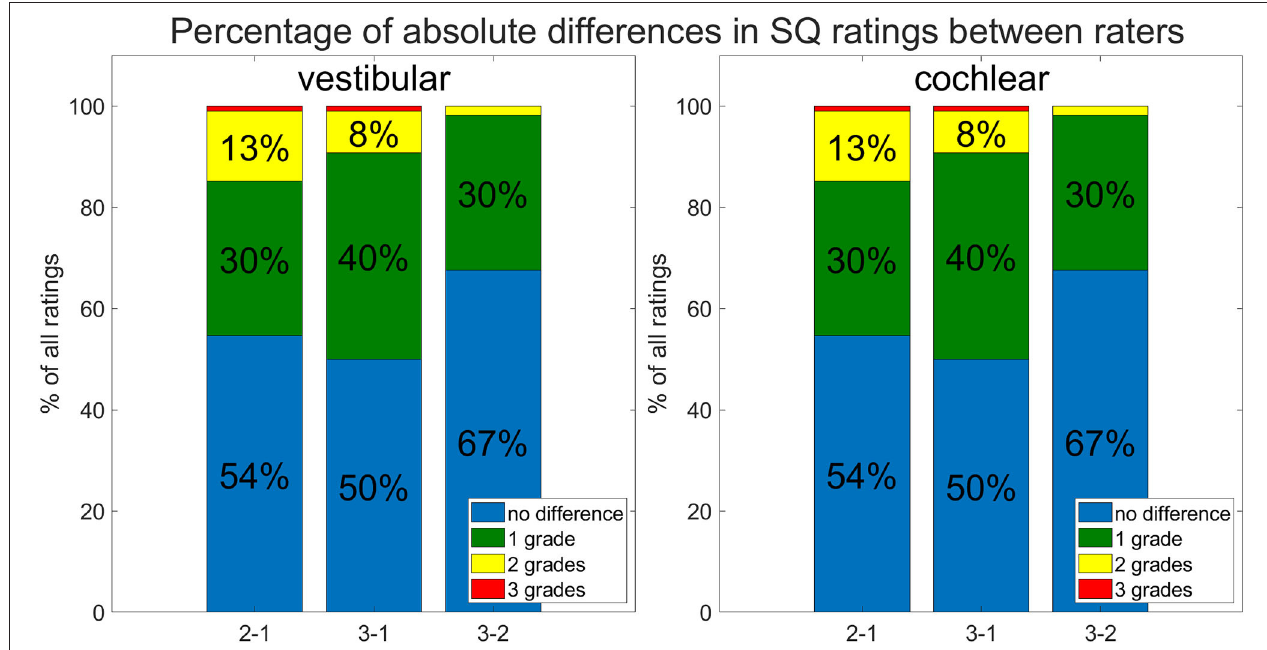
FIGURE 4 | Inter-rater and -threshold between ELH quantification methods (belonging to question ii). Shown are differences between the three raters. The differences between raters are shown as percentages of the total number of subjects rated. Most grades between raters agree (no difference; in blue), and the next largest difference was by 1 grade (in green), the remaining differences between raters were mostly 2 grades (in yellow) and rarely 3 grades (in red)